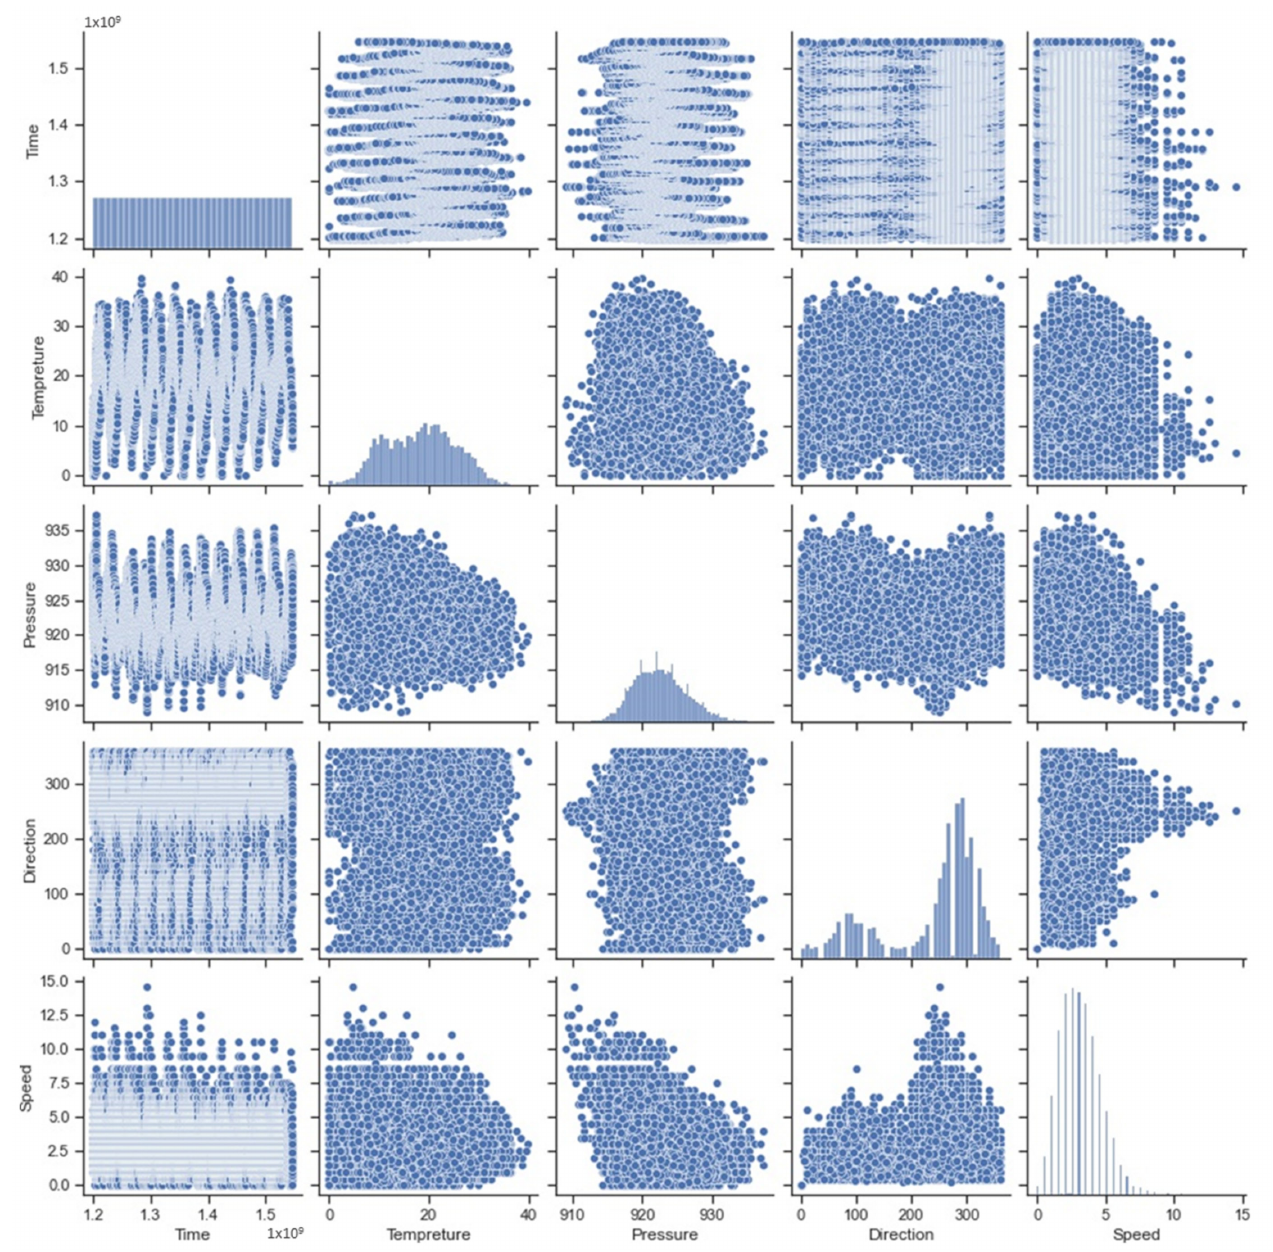
Figure 4. Dataset visualization that shows the distribution of single variables and the relationship between any two